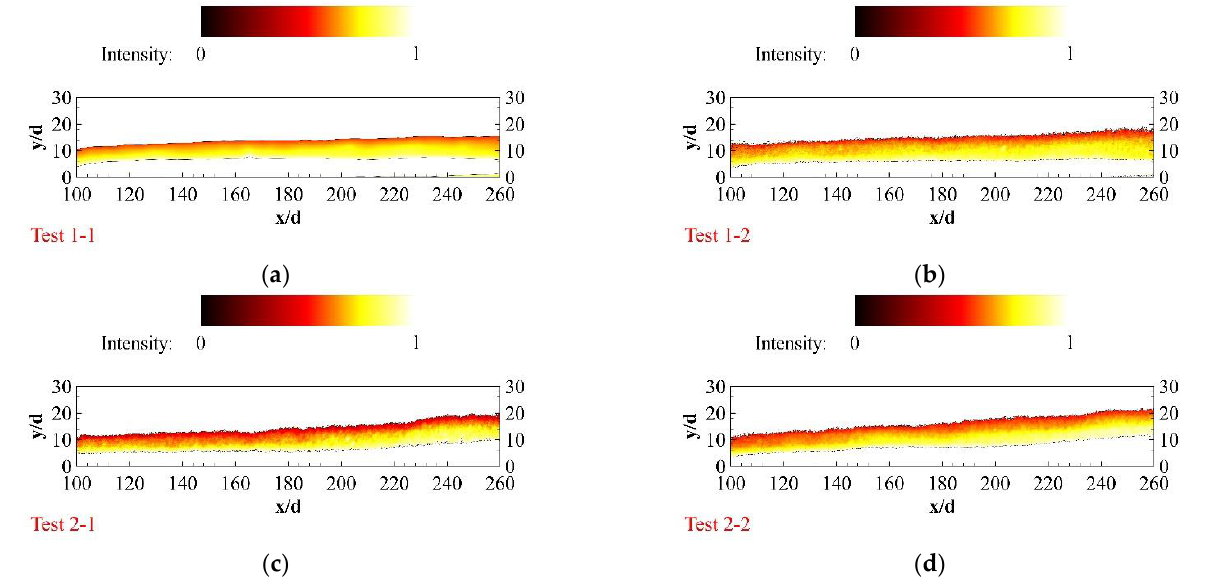
Figure 10. Central plume structures of EHF jet injected into Ma 2.0 crossflow. ( a ) Ma = 2.0, P j = 2.8 MPa, T j = 705 K. ( b ) Ma = 2.0, P j = 2.8 MPa, T j = 730 K. ( c ) Ma = 2.0, P j = 4.2 MPa, T j = 707 K. ( d ) Ma = 2.0, P j = 4.1 MPa, T j = 735 K.